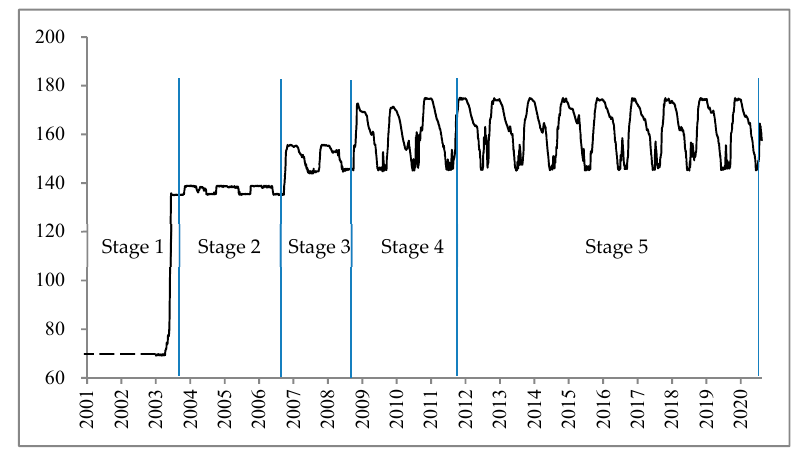
Figure 2. The water level in the TGD (unit: m) and division of impoundment periods.